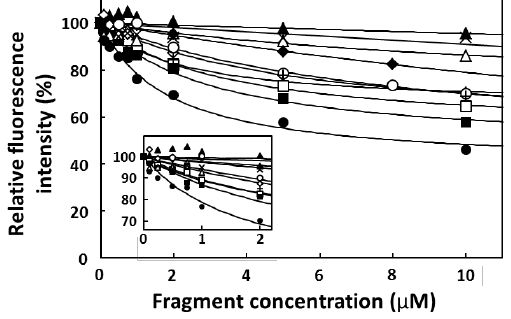
Figure 3. Titration curves for relative fluorescence intensity at 456 nm versus fragment concentration: CA-70 (open squares), CA-40 (closed squares), CA-23A (crosses), CA-23B (x-marks), CA-20 (open triangles), CA-19 (closed triangles), CA-18A (open diamonds), CA-18B (closed diamonds), CA-17 (open circles), and CA-16 (closed circles). CPT1 fluorescence without fragment was set at